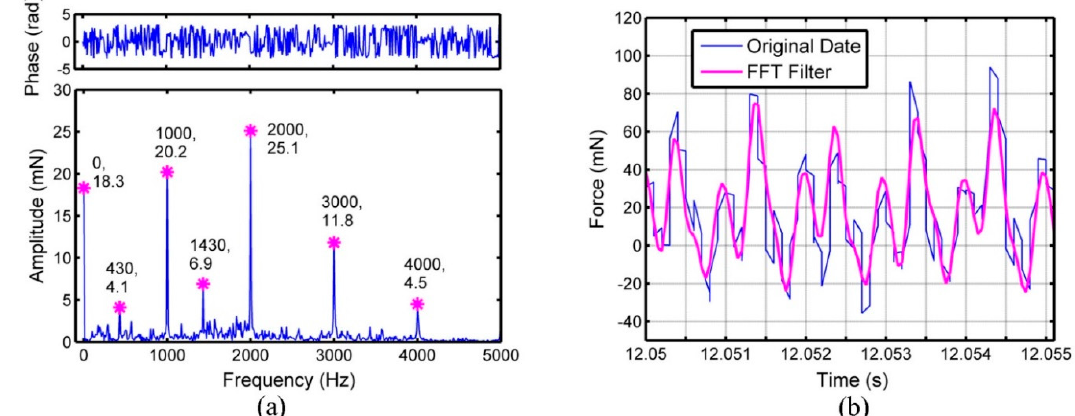
Figure 5. The cutting force signals of thrust direction ( F z ): ( a ) FFT analysis on thrust force, ( b ) comparative curves between original data and data after FFT filtering.